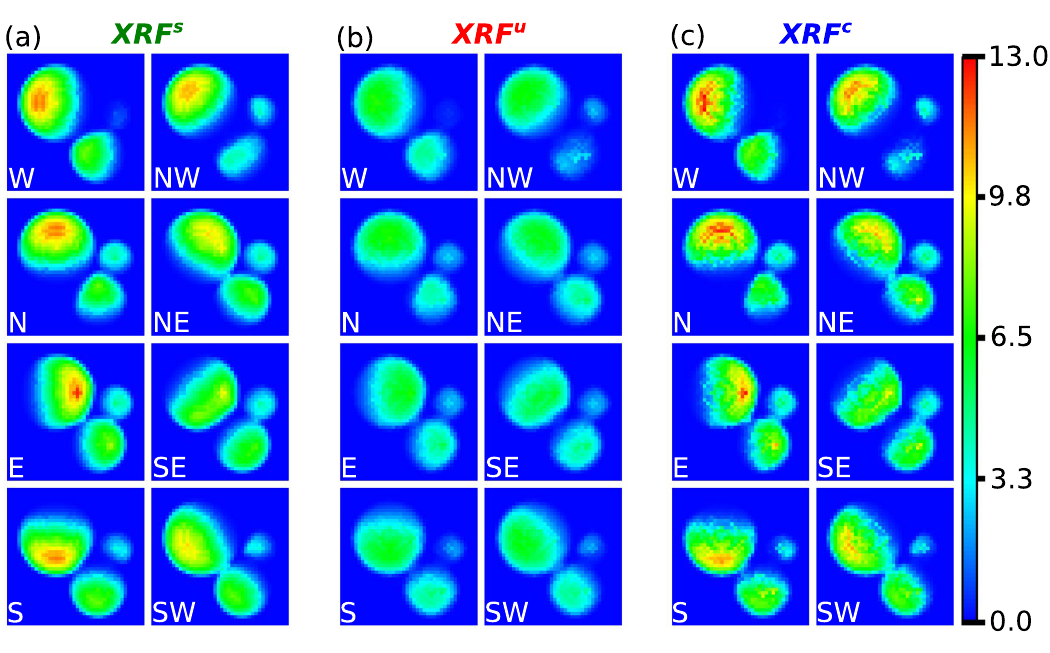
Figure 5. XRF 2 D maps for the K α line of C of the XRF displayed with the same logarithmic range. Each column displays images for all 8 SDDs comprising the LEXRF system, namely the West (W), North-West (NW), North (N), North-East (NE), East (E), South-East (SE), South (S) and South-West (SW)